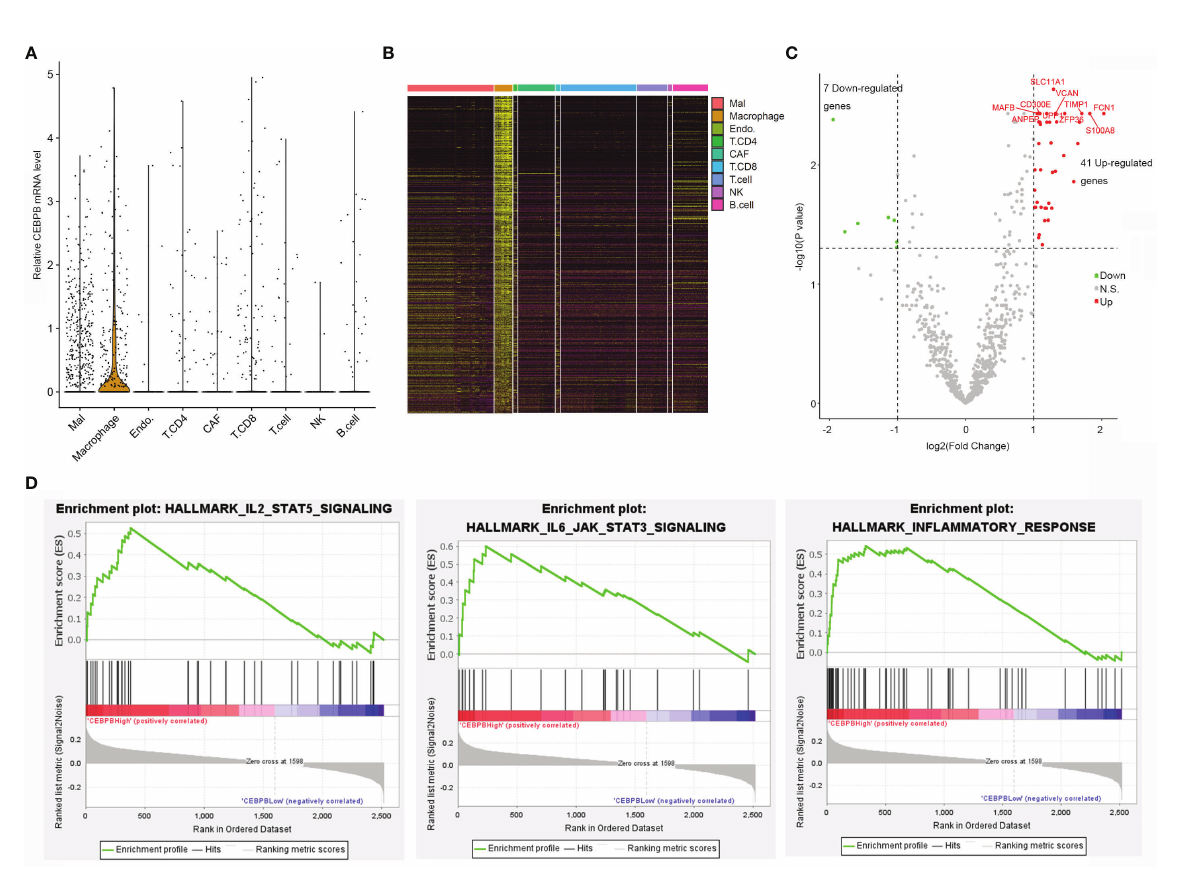
FIGURE 3 CEBPB is mainly expressed in macrophages of metastatic SKCM TME and associated with the immune activity of macrophages. (A) Distribution of CEBPB expression across different cell types in the metastatic SKCM TME. (B) Heatmap illustrating the expression of macrophage-speci fi c markers across different cell types in the metastatic SKCM TME. (C) Volcano plot of differential expression analysis between macrophages with CEBPB FPKM > 1 and those macrophages without CEBPB detected. Only macrophage-speci fi c genes were included in this analysis, and CEBPB itself was not included in this plot. Green, red, and gray dots represent genes that were signi fi cantly downregulated, upregulated, and non- signi fi cant in CEBPB FPKM > 1 macrophage compared with those without CEBPB detected. (D) Enrichment plot of three signi fi cantly